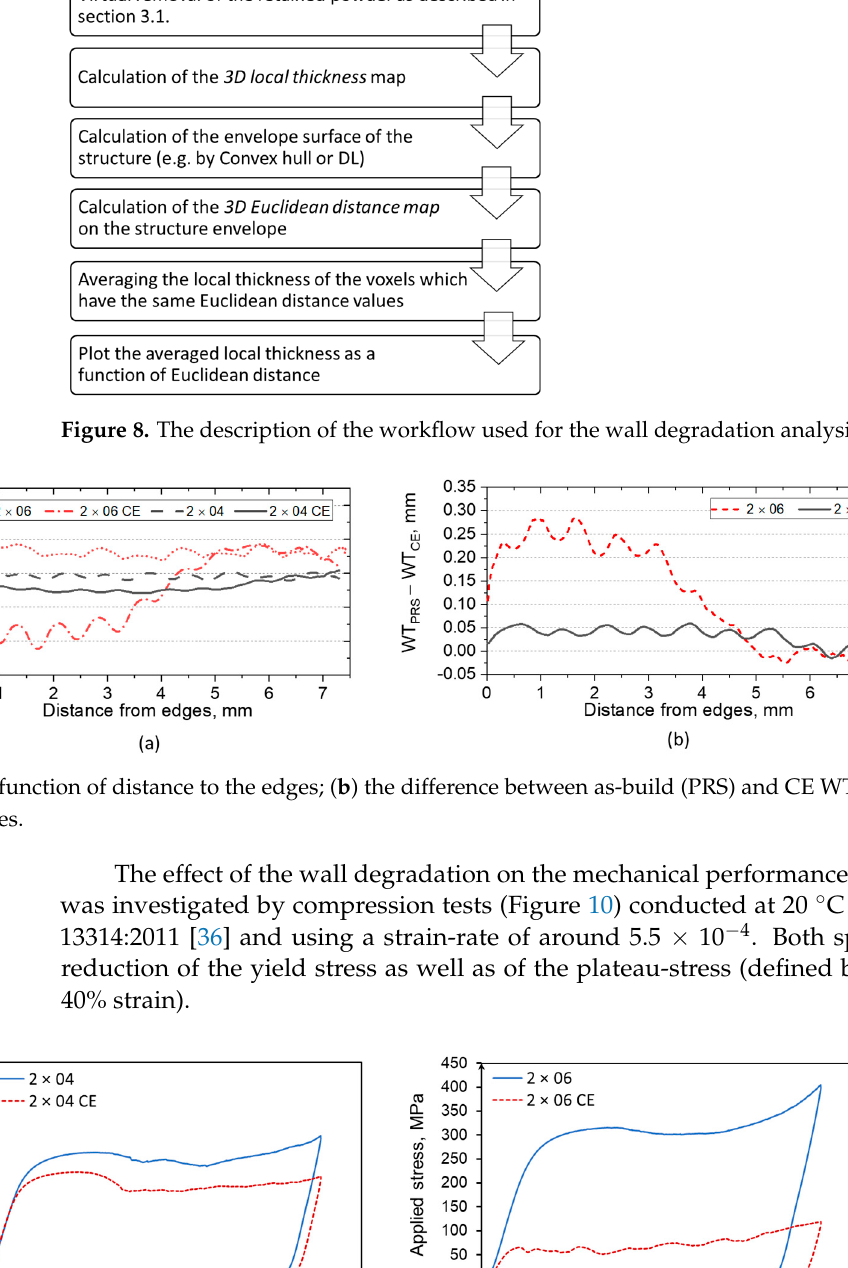
Figure 8. The description of the workflow used for the wall degradation analysis.